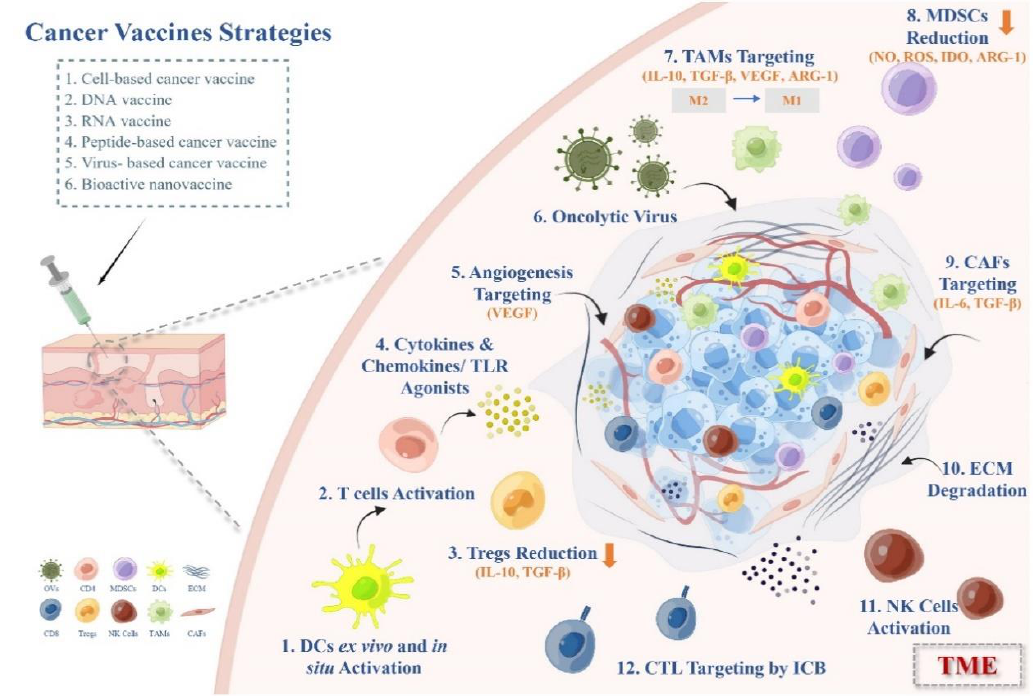
Figure 2. Therapeutic strategies of cancer vaccines overcoming immunosuppressive TME in solid tumors.